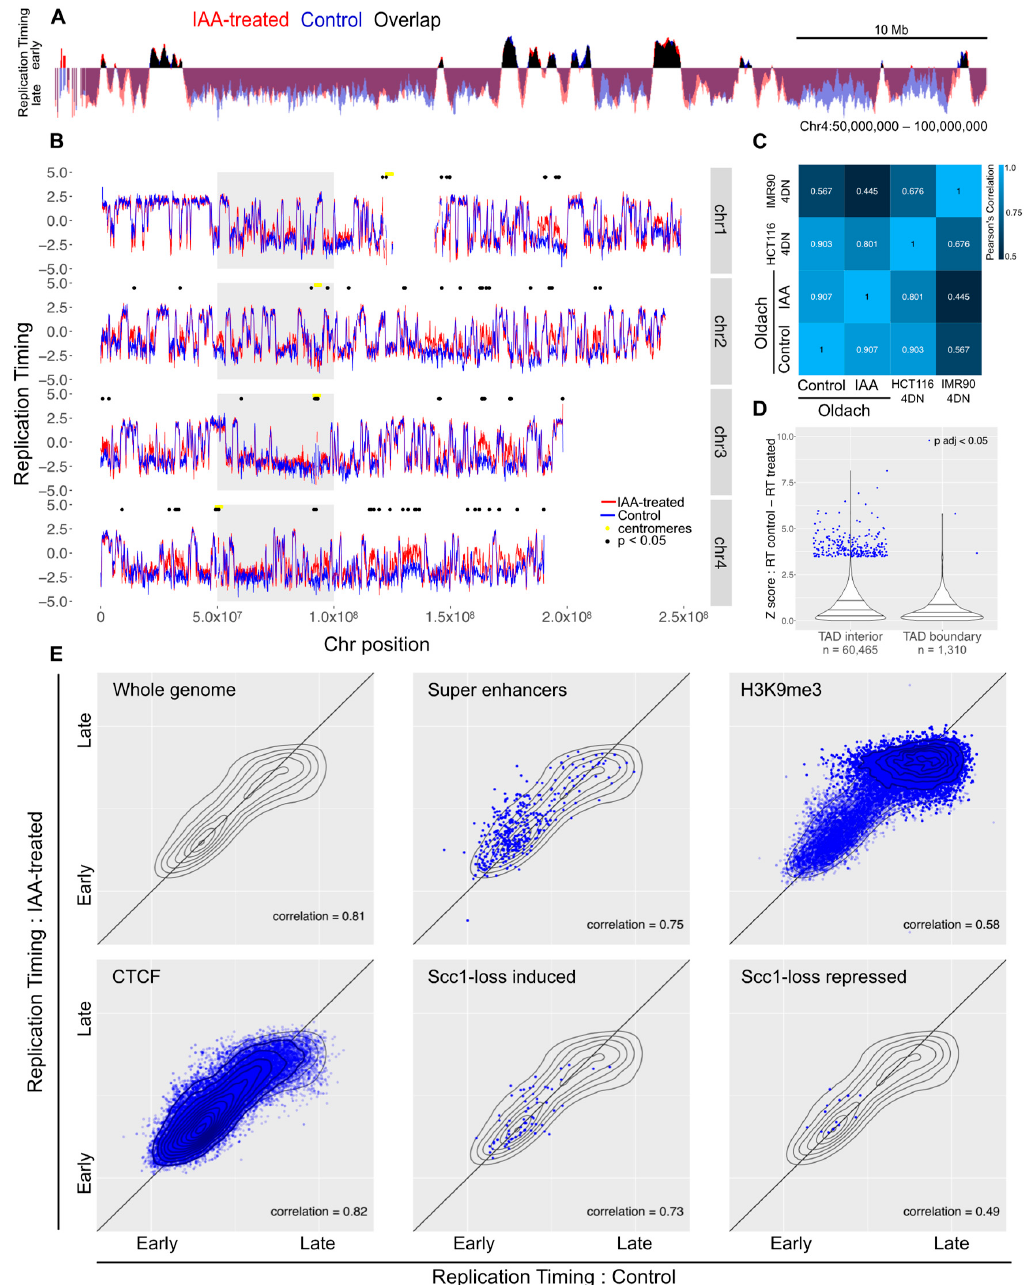
Figure 2. Acute loss of cohesin in S phase does not perturb replication timing. ( A ) Example locus overlay of replication timing (RT, log-scaled ratio of read counts in early over late S phase bin) for auxin-treated versus control cells. ( B ) RT plots for four example chromosomes with significantly-changed loci marked with black dots. The gray box highlights the region shown in ( A ). ( C ) Pearson correlation calculated for RT values across the genome compared to previously-published 4D Nucleome RepliSeq data. ( D ) Violin plot showing the distribution of Z scores for control versus auxin-treated RT difference across the genome, separating out genomic bins covering a TAD boundary. ( E ) RT for control versus auxin-treated cells across the whole genome, and across genomic coordinates annotated for super enhancers, H3K9me3, CTCF, and genes that showed induction or repression upon auxin treatment in the Scc1-mAID cell line. The gray topology plot in each subfigure shows the whole-genome behavior and genome features with dense annotations (CTCF and H3K9me3) have a topology map in dark